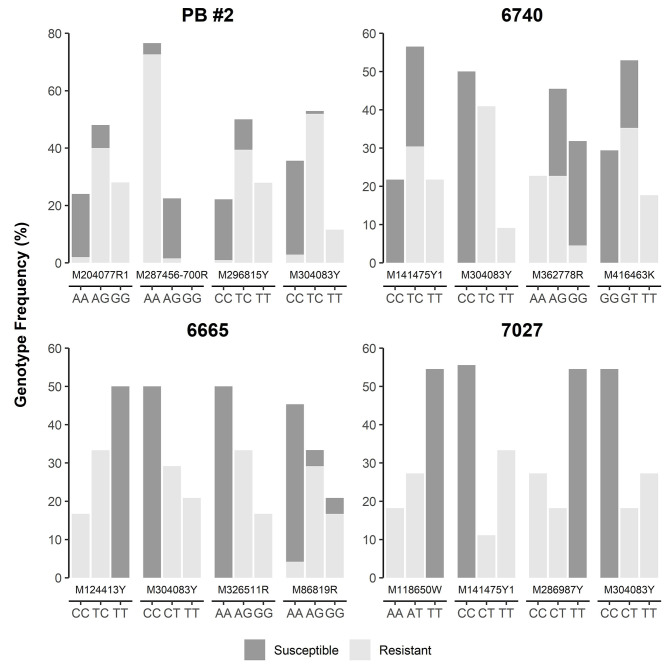
Genotype frequency of the SNP loci that showed co-segregation or significant association with resistance to Cronartium ribicola in four Alberta open-pollinated seed families.